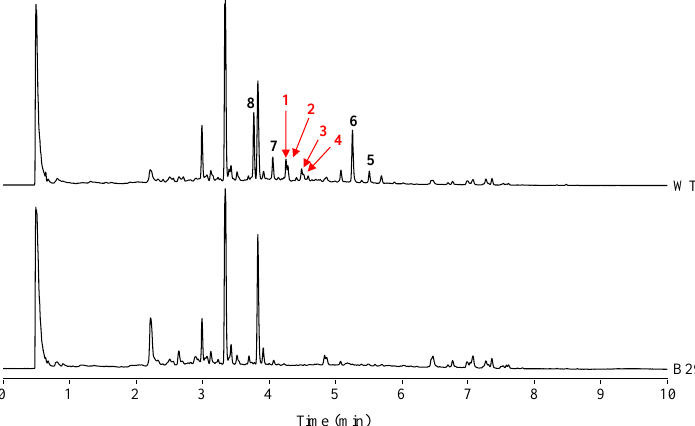
Figure 1. UPLC chromatograms, monitored at 238 nm, of S. albus J1074 (wt) and S. albus B29 (B29). Extracts were generated from cultures of the strains in MFE liquid medium during 96 h. Labeled peaks correspond to novel paulomycin derivatives ( 1 – 4 ), paulomycin A ( 5 ), paulomycin B ( 6 ), paulomenol A ( 7 ), and paulomenol B ( 8 ).